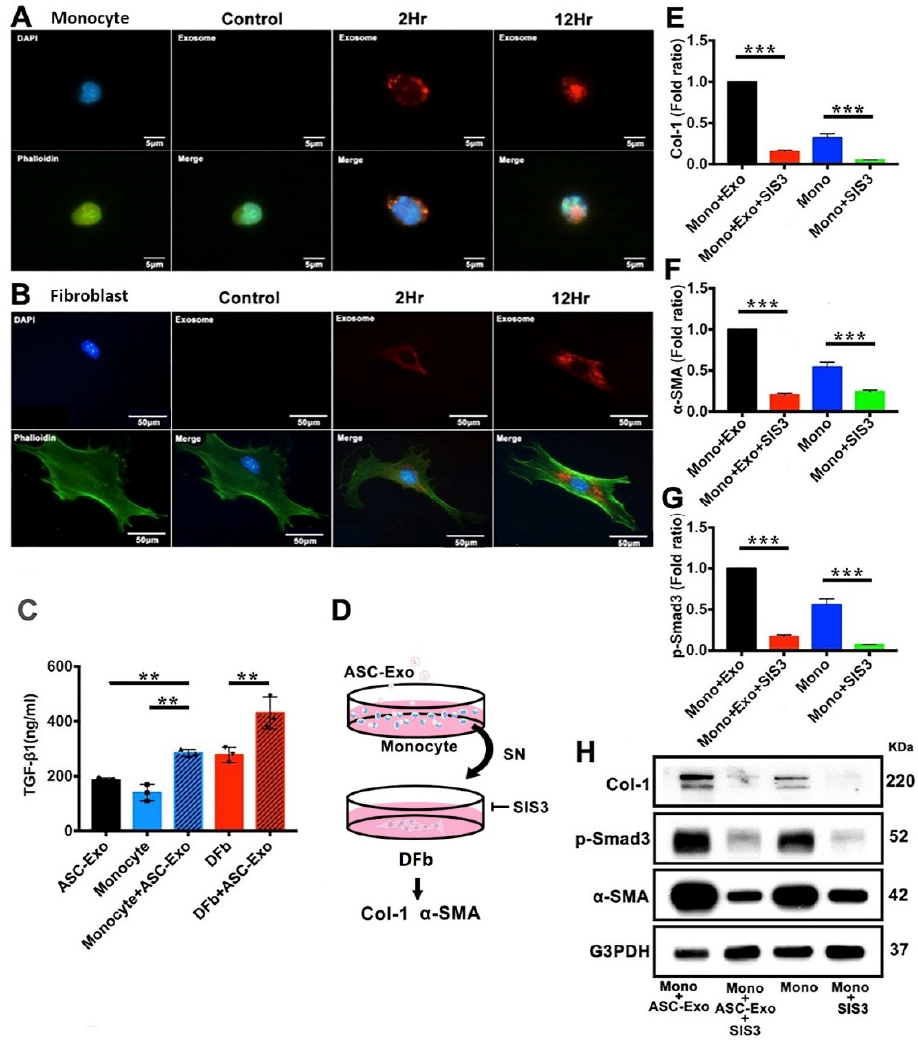
Figure 6. Cell internalization of ASC-Exo in cultured monocytes and dermal fibroblasts (DFb) of diabetic mice and role of ASC-Exo in Smad3-dependent TGF- β stimulation of ECM production. ( A ) Cellular uptake of ASC-Exo in cultured monocytes by confocal microscopy demonstrated rapid uptake of ASC-Exo. Merged images of DAPI-labelled nucleus (blue), R18-labelled ASC-Exo (red), and phalloidin-labelled cytoskeleton (green) revealed localization of ASC-Exo around the cells at 2 h and into the cells at 12 h. ( B ) ASC-Exo uptake by cultured dermal fibroblasts. ( C ) ASC-Exo treated monocytes and dermal fibroblasts increase the production TGF- β 1. TGF- β 1 levels were measured using enzyme-linked immunosorbent assay (** p < 0.01). Data were expressed in means ± SE, n = 3/group, Student’s t -tests. ( D ) Experimental design of SIS3, a specific inhibitor of Smad3, on TGF- β 1 dependent Smad3 phosphorylation and extracellular matrix production in cultured DFb. The DFb cultures were serum-starved for 24 h and treated with 3 µ M SIS3 for 1 h, and then supernatant of ASC-Exo-treated monocyte culture was added. After 48 h, the conditioned media were subjected to immunoblotting with antibodies for Col-I, α -SMA, p-Smad3, and β -actin, respectively. One representative of four independent experiments is shown. Error bars are mean ± SE. Data were analyzed using independent unpaired two-tailed Student’s t -tests or 1-way ANOVA with Bonferroni correction. ( E – H ) SIS3 inhibited the protein expression of Col-I, α -SMA, and p-Smad3 induced by supernatant of ASC-Exo-treated monocyte culture in dermal fibroblasts. Data are expressed as the mean ± SE of four independent experiments. *** p < 0.001 compared with the value in the supernatant of ASC-Exo-treated monocyte culture treated DFb without